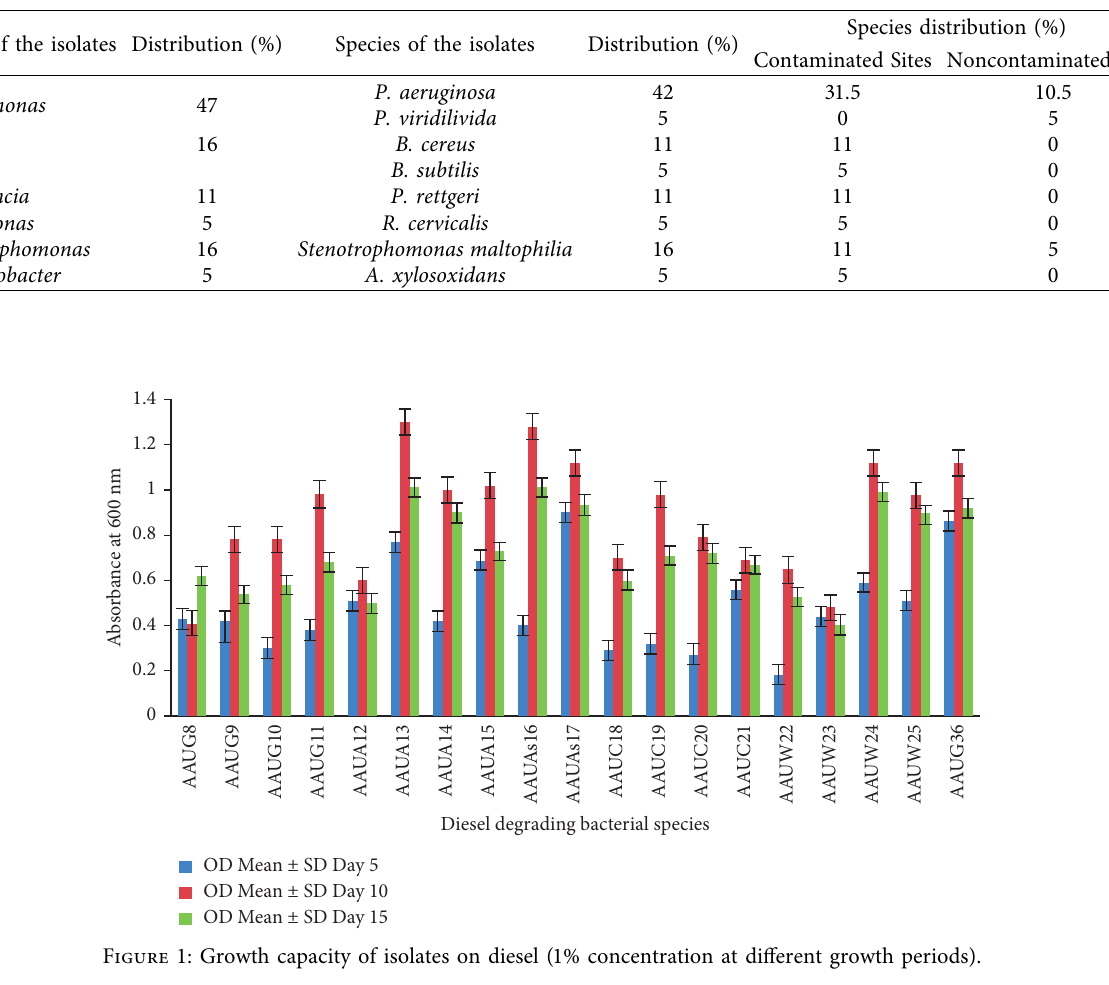
Table 2: Diversity and community structure of isolates from hydrocarbon-contaminated sites and nonpolluted natural sites (Chitu Soda lake).